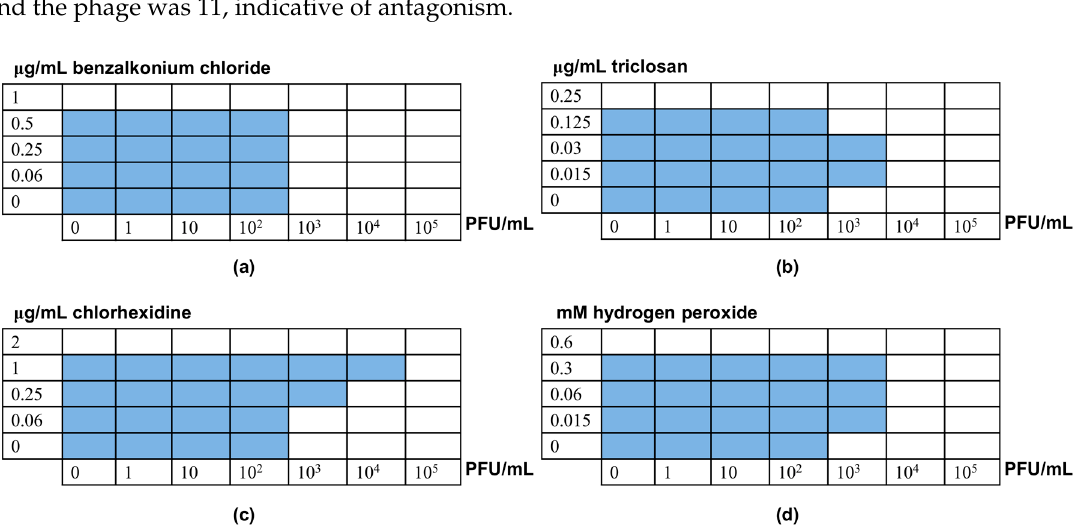
Figure 2. Results of the checkerboard assays to test the interactions between phage phiIPLA-RODI and the following disinfectants: ( a ) benzalkonium chloride; ( b ) triclosan; ( c ) chlorhexidine; ( d ) hydrogen peroxide. Wells with bacterial growth after 24 h of incubation at 37 °C are marked in blue.